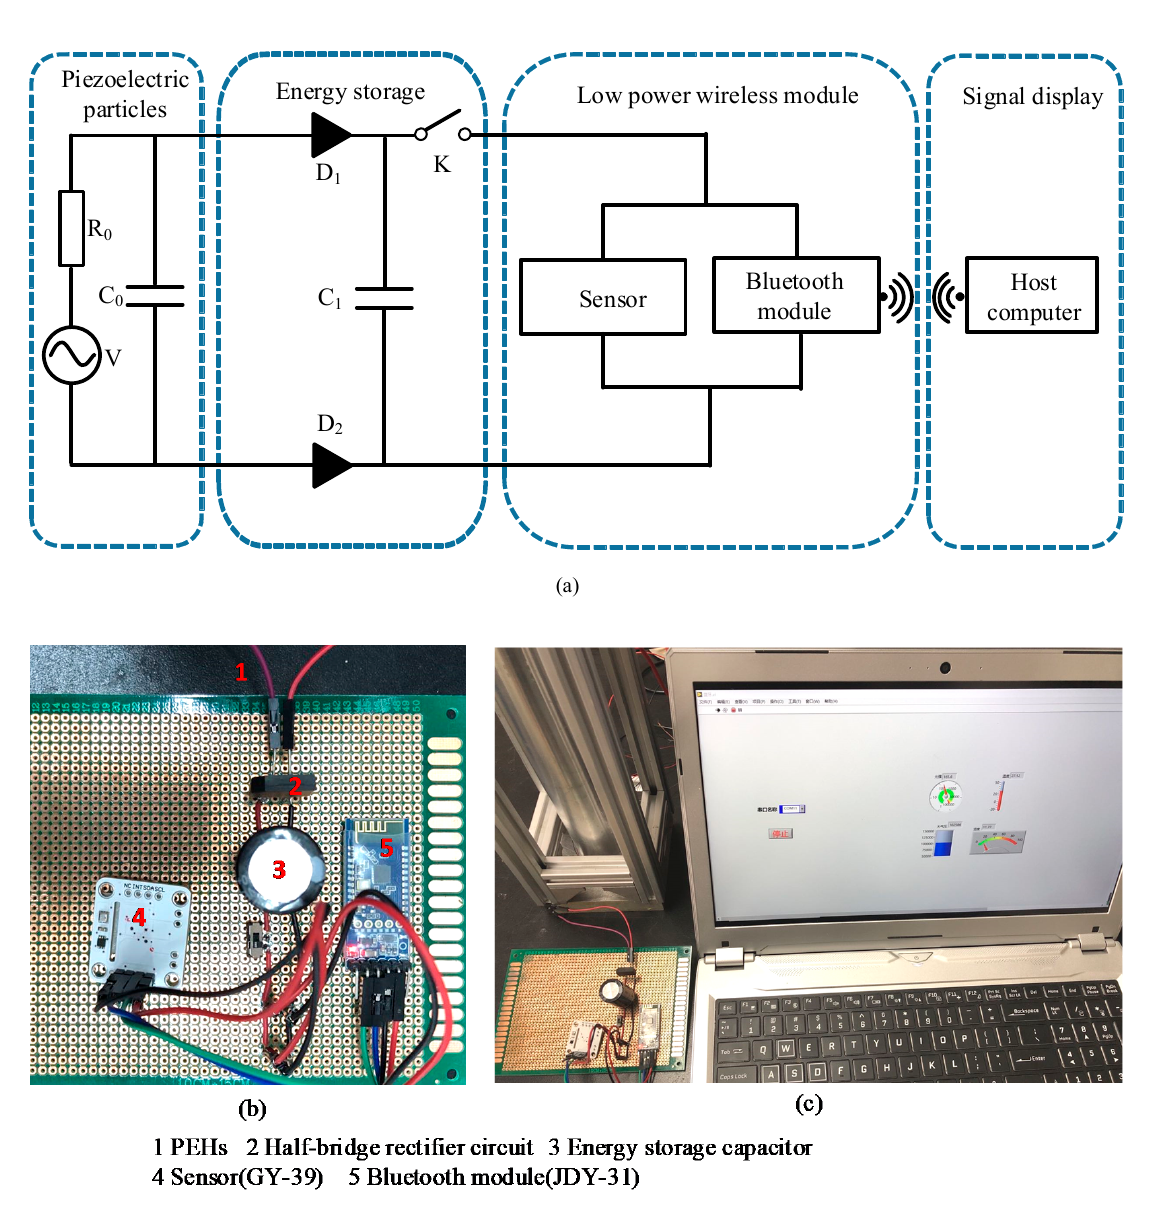
Figure 9. ( a ) Schematic diagram and ( b ) photo of the self-powered wireless meteorological sensor, and ( c ) the signal acquisition diagram of the host computer .